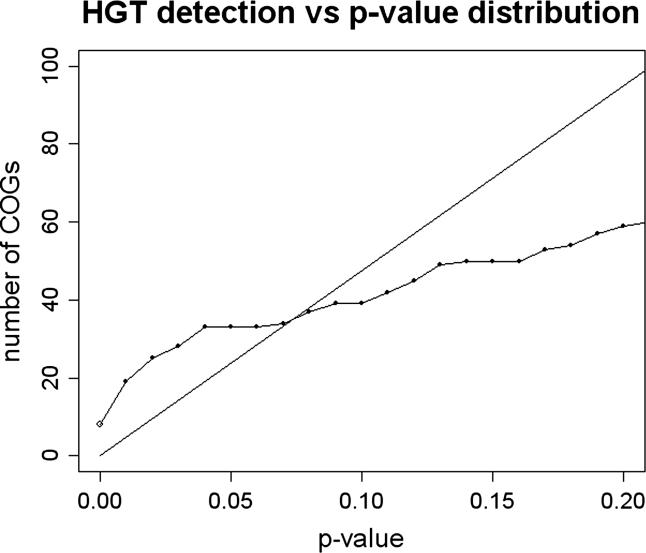
The Relationship between Detecting COG Entries with HGT and the p-ValuesDotted curve: the number of COG entries detected to contain HGT at given p-value cutoffs. Straight line: the number of COG entries identified to contain HGT merely by chance, based on given p-value cutoffs. When the cutoff for p-value increases, the number of COG entries that might contain HGT increases, as one would expect. However, the small slope of this curve compared with the line of null hypothesis suggests that the frequency of HGT does not change dramatically, even in a relatively flexible p-value range.